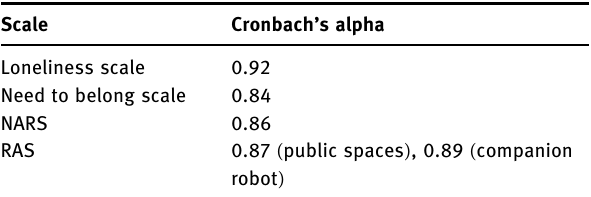
Table 2: Results of the reliability ( internal consistency ) of all scales used in the study Scale Loneliness